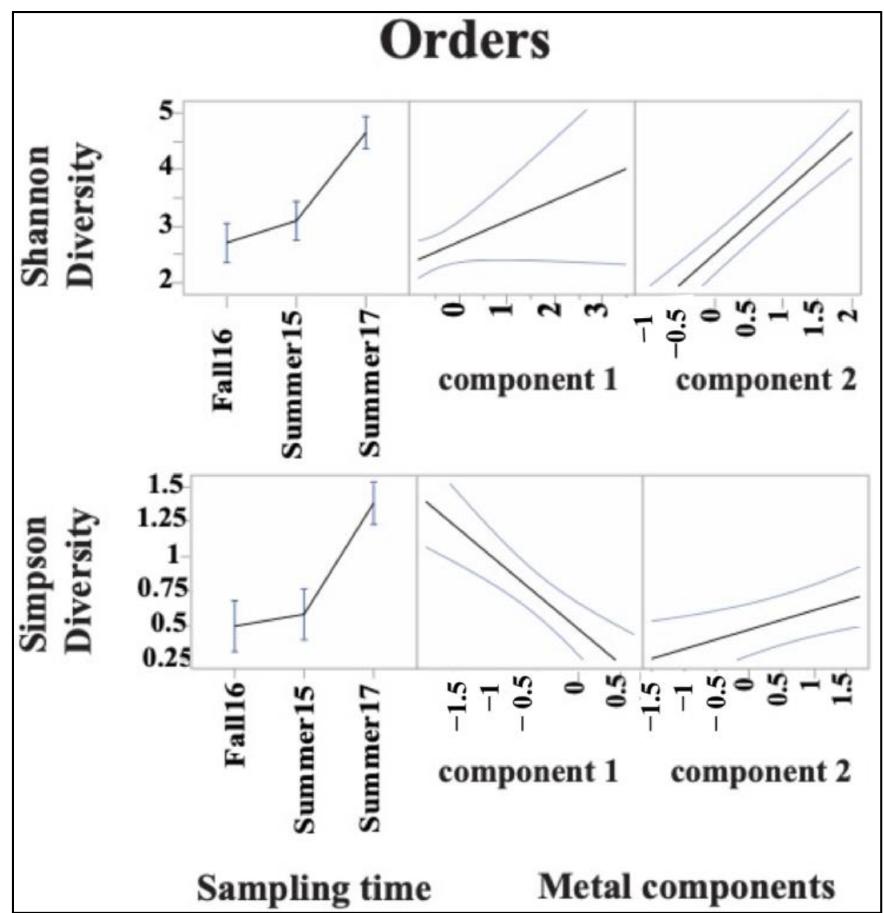
Figure 7. Prediction profiles from ANOVA showing the effect of metal component 1 and 2 (from principal component analysis) on the Shannon and Simpson diversity indices identified as taxonomic order from wetland sites 1–6 during fall 2016 and summer 2015 and 2017. The blue-lined area in each profile represents the 95% prediction confidence interval of the response variable. The profiler was set to metal component 1 at − 0.0516 and metal component 2 at 0.1825 in the case of Shannon and Simpson diversity,